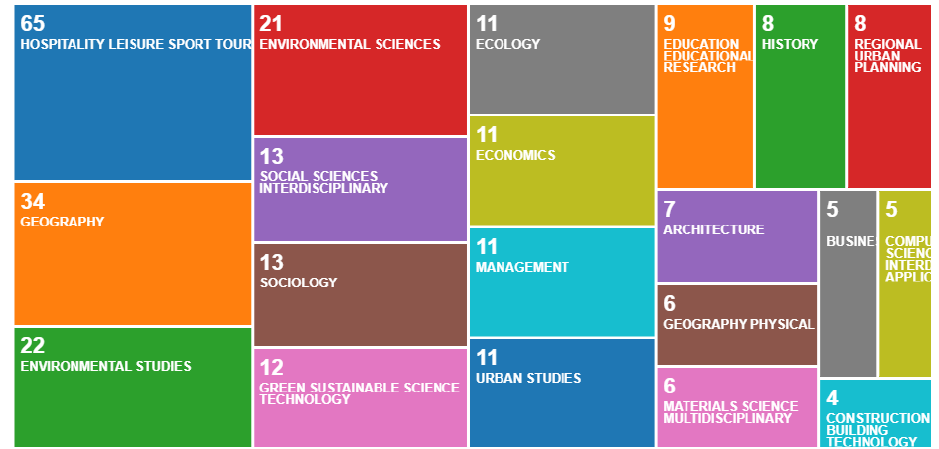
Figure 1. Visualizing Treemap with selected 20 results. Publication count from Web of Science (WOS) Research areas.